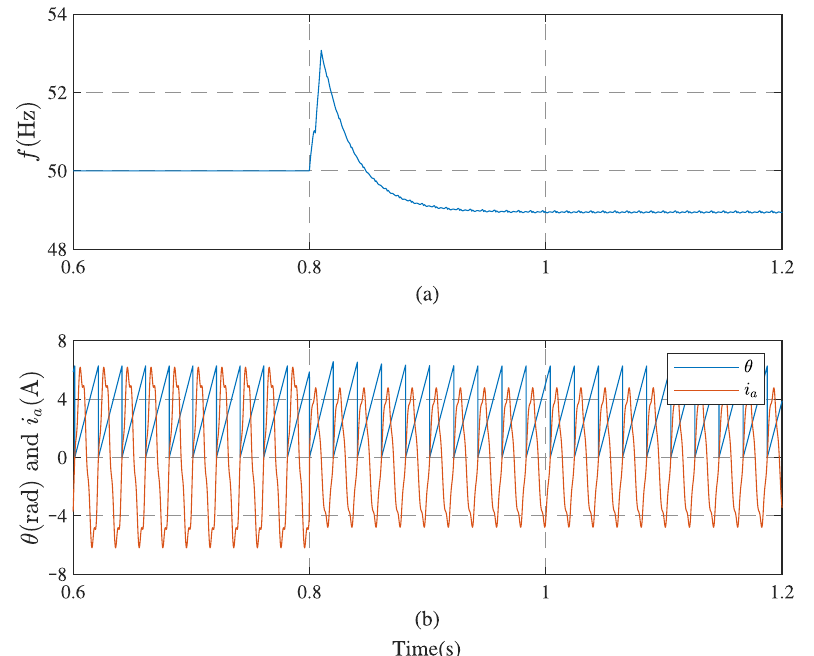
Figure 8. Simulation results with frequency and amplitude jump: ( a ) frequency, ( b ) comparison between θ and i a